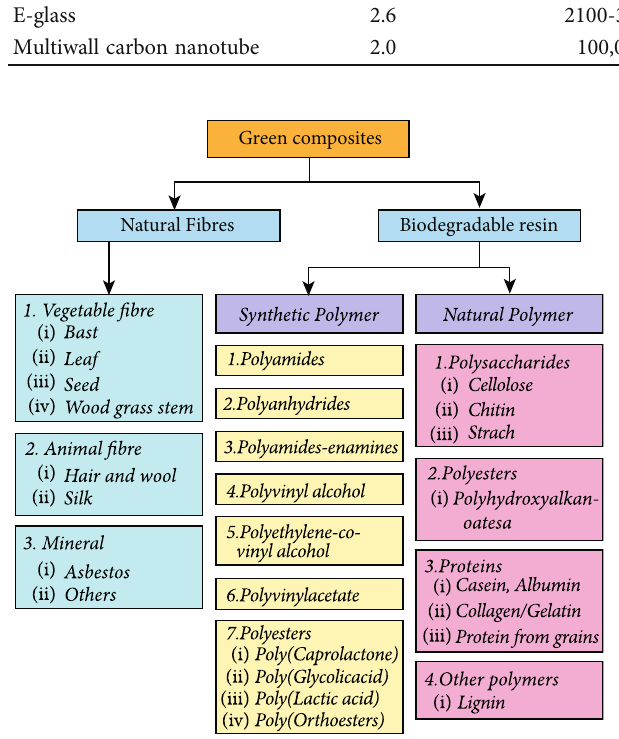
Figure 1: Di ff erent materials for composites. Table 2: Epoxy matrix properties